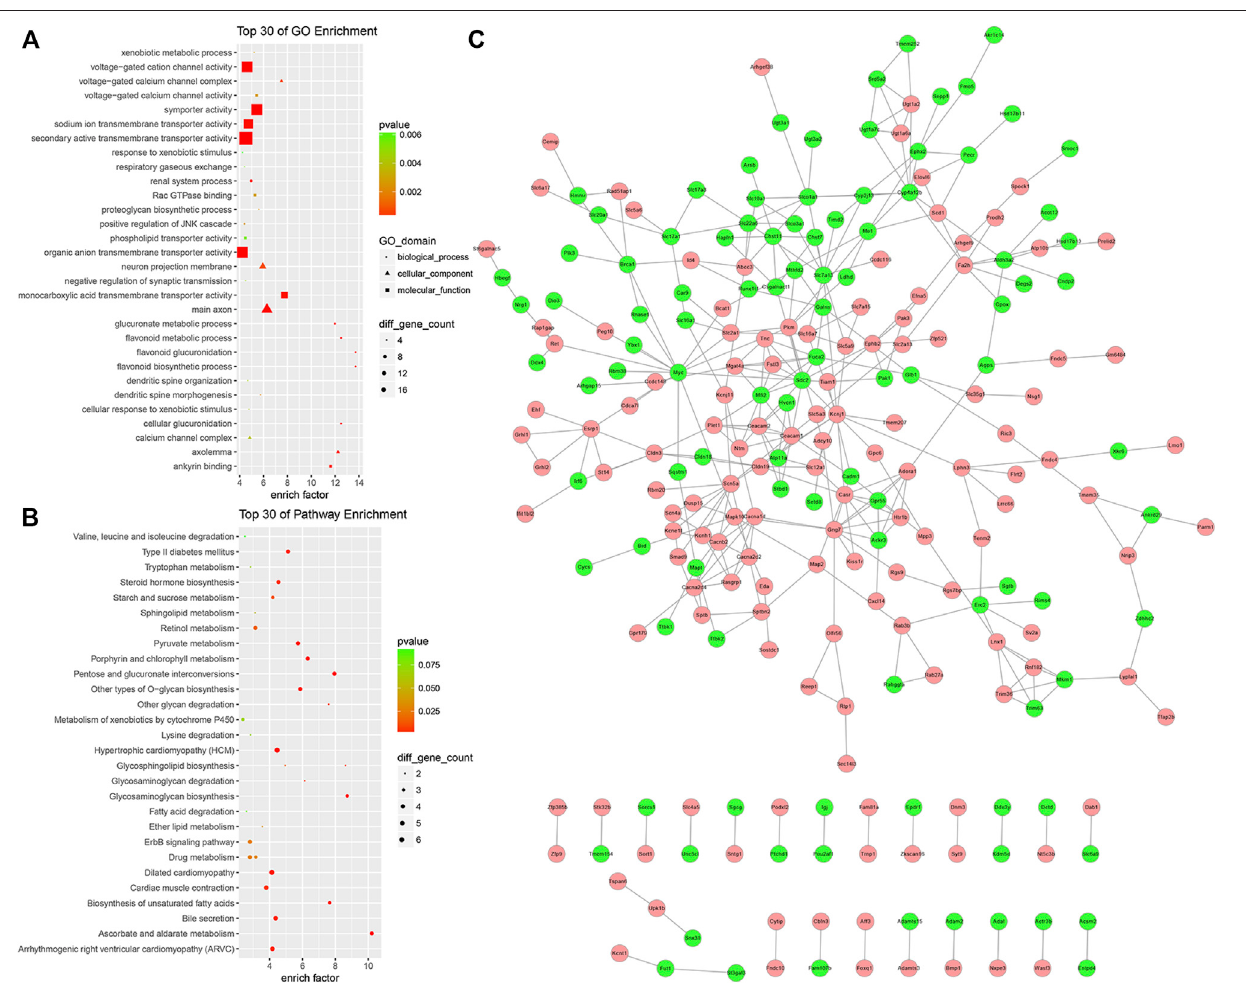
FIGURE7| GOenrichment analysis, KEGGenrichmentanalysis,and PPInetworkofthecircRNA ceRNA network. (A) GOEnrichmentannotationofcircRNAs. (B) KEGGpathwayenrichmentofcircRNAs. (C) PPInetworkofthecircRNAceRNAnetwork.Pinkandgreennodesdenoteupregulatedanddownregulatedprotein-coding genes, respectively. PPI, protein-protein interaction.